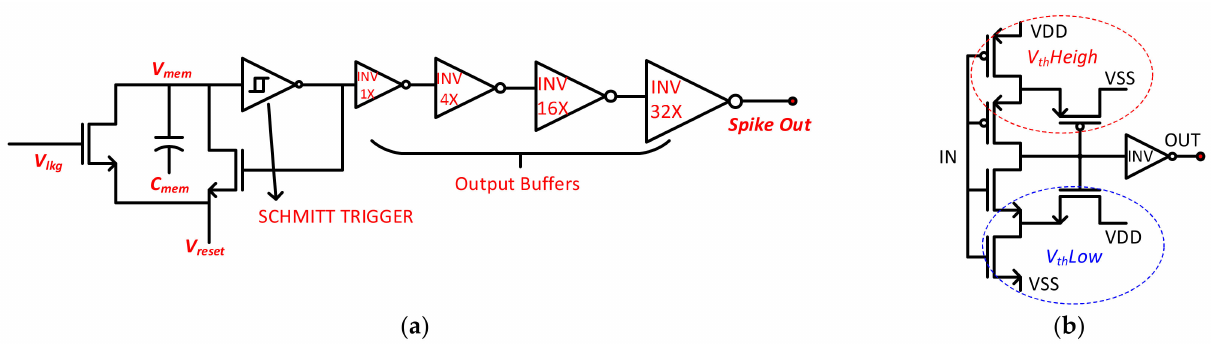
Figure 3. ( a ) The circuit schematic of the LIF-based neuron; ( b ) The circuit schematic of the Schmitt Trigger used inside the neuron